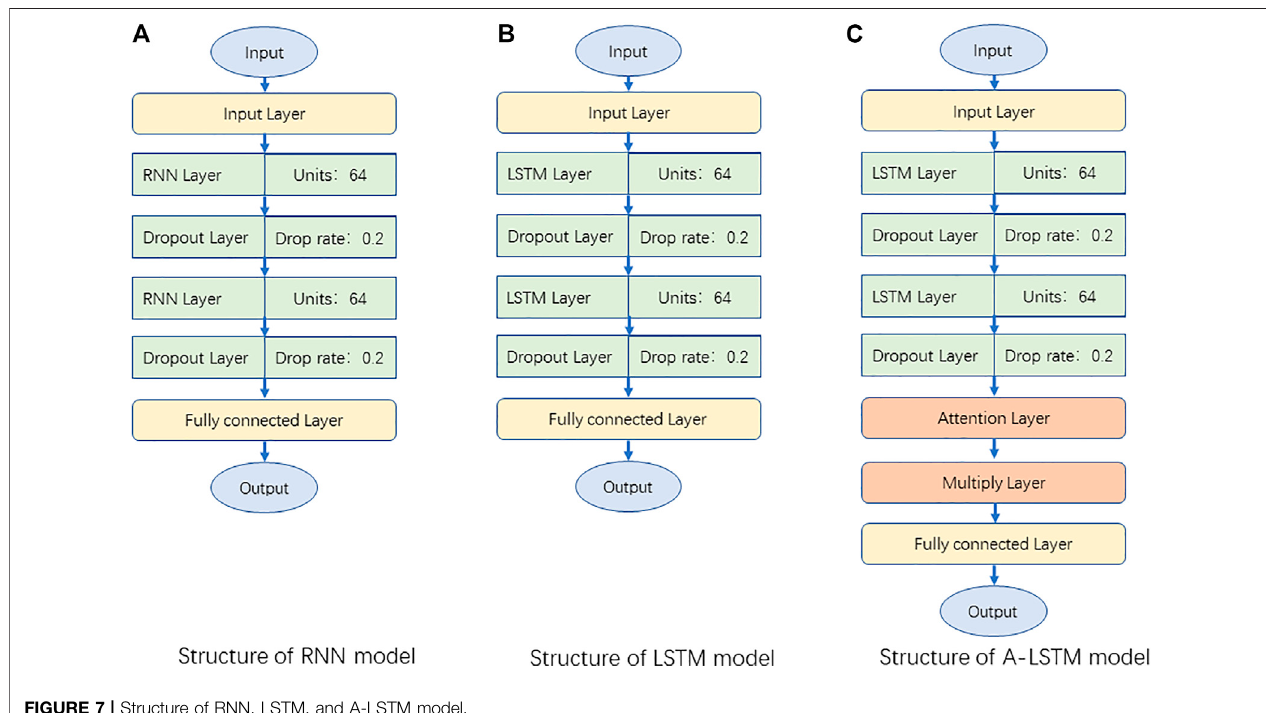
FIGURE 7 | Structure of RNN, LSTM, and A-LSTM model.